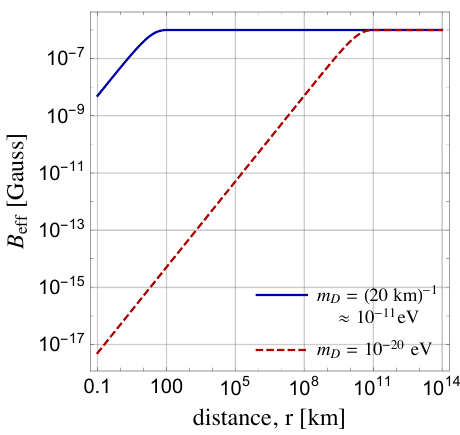
Figure 1 . Radial profile of the galactic magnetic field felt by a dark monopole with ε = 1 , for two choices of dark photon mass, and constant galactic field B = 3 × 10 − 6 G. Here r is the distance between the dark monopole and the source of an ordinary magnetic